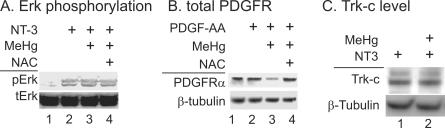
MeHg Effects Are Pathway Specific and Are Associated with Reduced Levels of PDGFRα(A) MeHg does not inhibit ERK1/2 phosphorylation induced by exposure to NT-3. Cells were grown as in Figure 2A, but exposed to NT-3 instead of PDGF. As shown, MeHg exposure did not reduce the extent of ERK1/2 phosphorylation induced by exposure to NT-3, thus indicating that the site of action of MeHg is not on the level of these kinases.(B) Consistent with the indication from these results that effects of MeHg were mediated further upstream in the PDGF-signaling pathway, analysis of cells treated in the same manner showed reductions in total levels of PDGFRα. The effects of MeHg on total levels of PDGFRα were prevented by co-exposure with NAC.(C) Exposure to MeHg was not associated with reductions in levels of TrkC, indicating that receptor loss was mediated by a mechanism that distinguishes between PDGFRα and TrkC.All experiments were repeated at least three times. The plus symbol indicates exposure of the cells to the indicated substance.